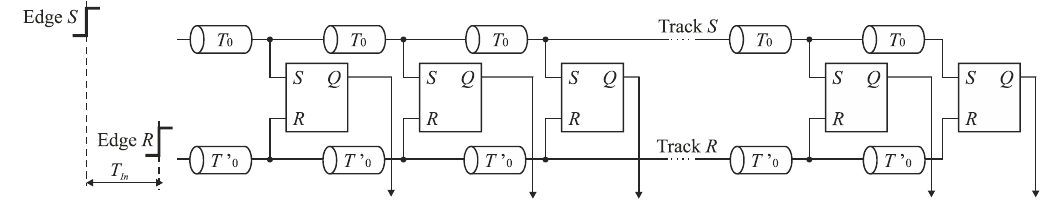
Figure 5. Diagram of Vernier delay line TDC.